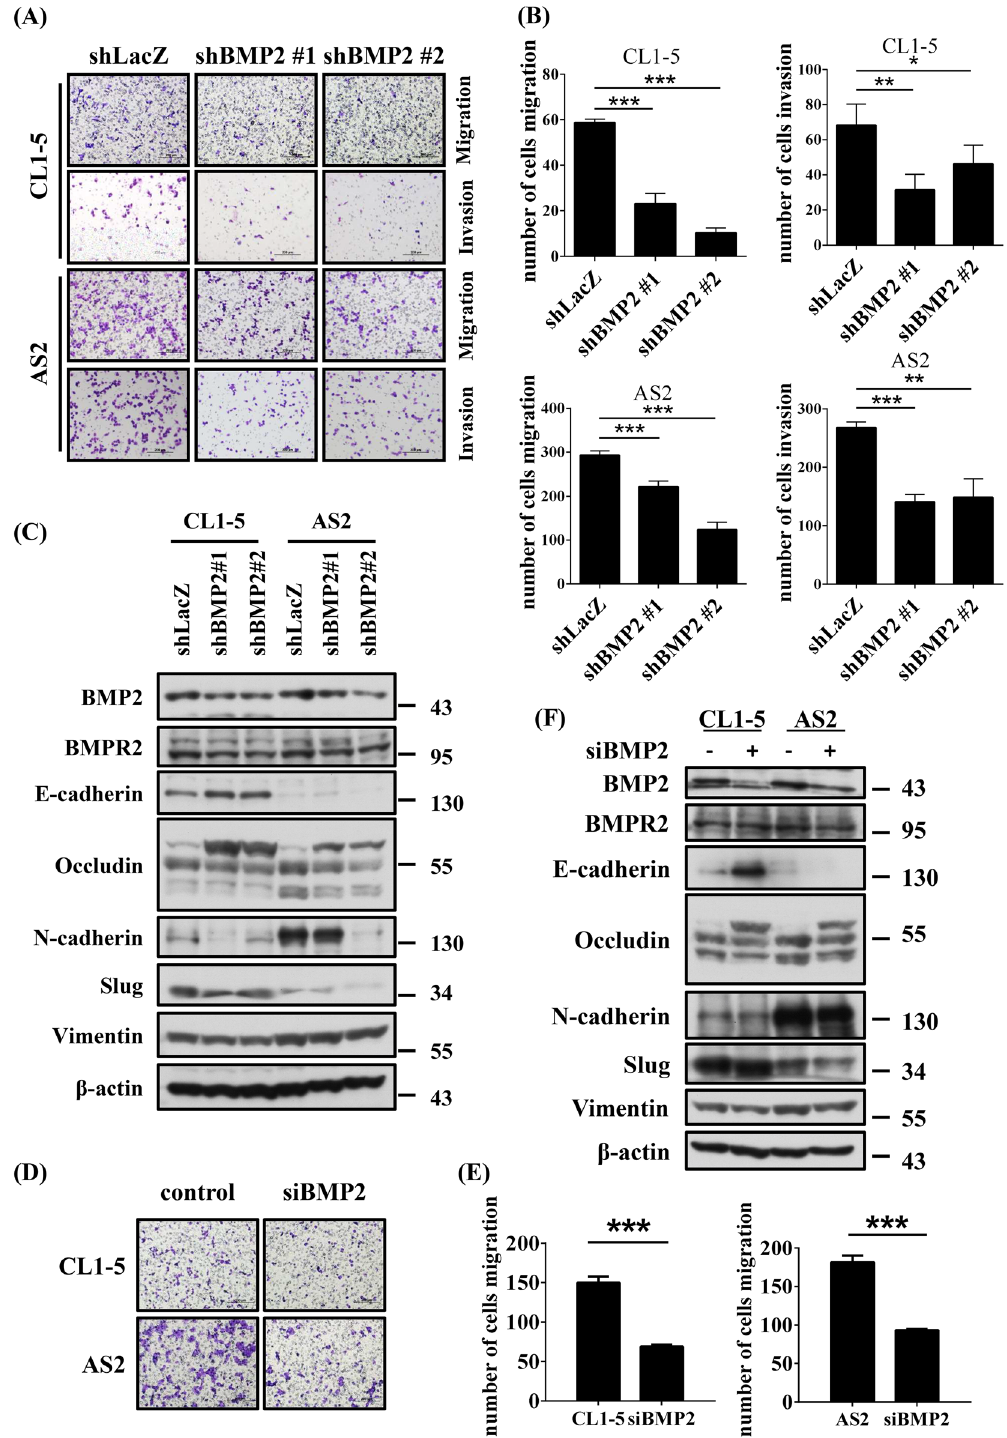
Figure 3. Inhibition of BMP2 reduces invasiveness and downregulates EMT in lung cancer cells. ( A ) The invasion and migration abilities were reduced in BMP2-depleted CL1-5 and AS2 cells. BMP2 expression was depleted by two specific shRNAs. shLacZ is the non-targeting control. Slides were observed under 10 × magnification. ( B ) Quantitative data derived from ( A ). Bar graphs represent the average number of migrated cells ± SD. At least three fields were counted and averaged for each cell line. ( C ) The protein levels of BMP2 and EMT marker were determined by western blotting in CL1-5 and AS2 cells. ( D ) Cell invasion and migration abilities were reduced in BMP2-depleted CL1-5 and AS2 cells. The expression of BMP2 was depleted by siRNA. A non-targeting siRNA was used as a control. Slides were observed under 10 × magnification. ( E ) Quantitative data derived from ( D ). Bar graphs represent the average number of migrated cells ± SD. At least three fields were measured in each cell line. ( F ) The expression levels of BMP2 and EMT markers were determined by western blotting. The p -value was determined by Student’s t test. (* p < 0.05, ** p < 0.01, *** p <